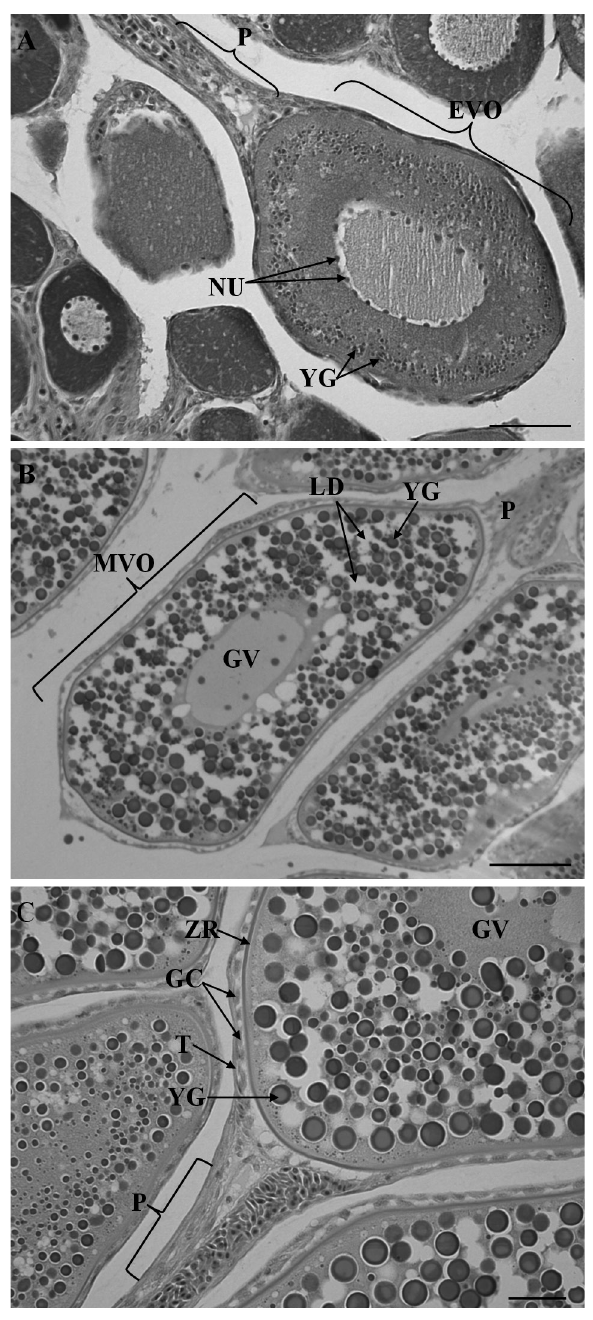
Fig . 5. – A, early vitellogenic stage oocyte (EVO) (scale bar: 50 µm); B, mid-vitellogenic stage oocyte (MVO) (scale bar: 100 µm); and C, follicular complex of vitellogenic stage oocyte (scale bar: 50 µm). GC, granulosa cells; GV, germinal vesicle; LD, lipid droplets; MVO, mid-vitellogenic stage oocyte; NU, nucleoli; P, peduncle; T, theca; YG, yolk granules; ZR, zona radiata.